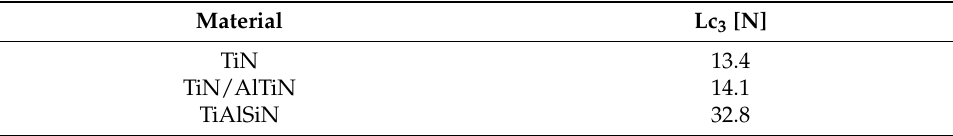
Table 5. Critical load values for TiN, AlTiN and TiAlSiN